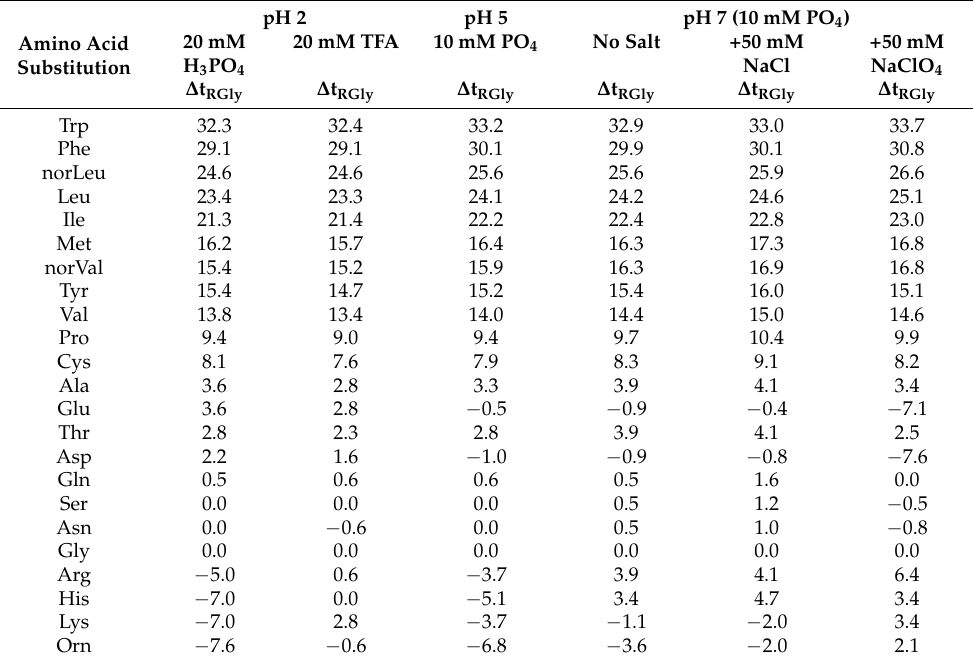
Table 9. Hydrophobicity coefficients in five different mobile phases (absence of the nearest group effect)